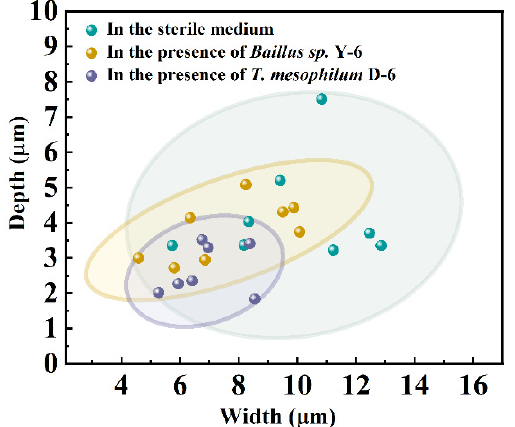
Figure 6. Statistical analysis of pit width/depth after 7 days incubation in different cultures. The green, orange and purple dots represent the result of the sterile medium, Bacillus sp. Y-6 and T. mesophilum D-6 culture, respectively.